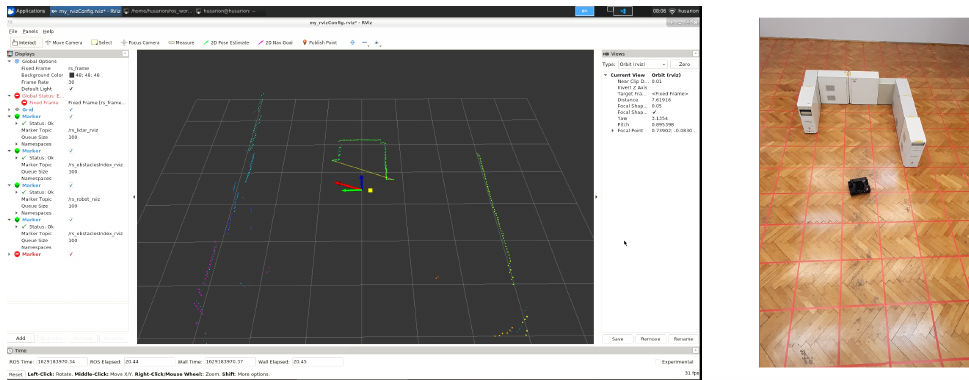
Figure 10. Real photo and RViz visualization at the same timestamp as the image number III in Figure 9.